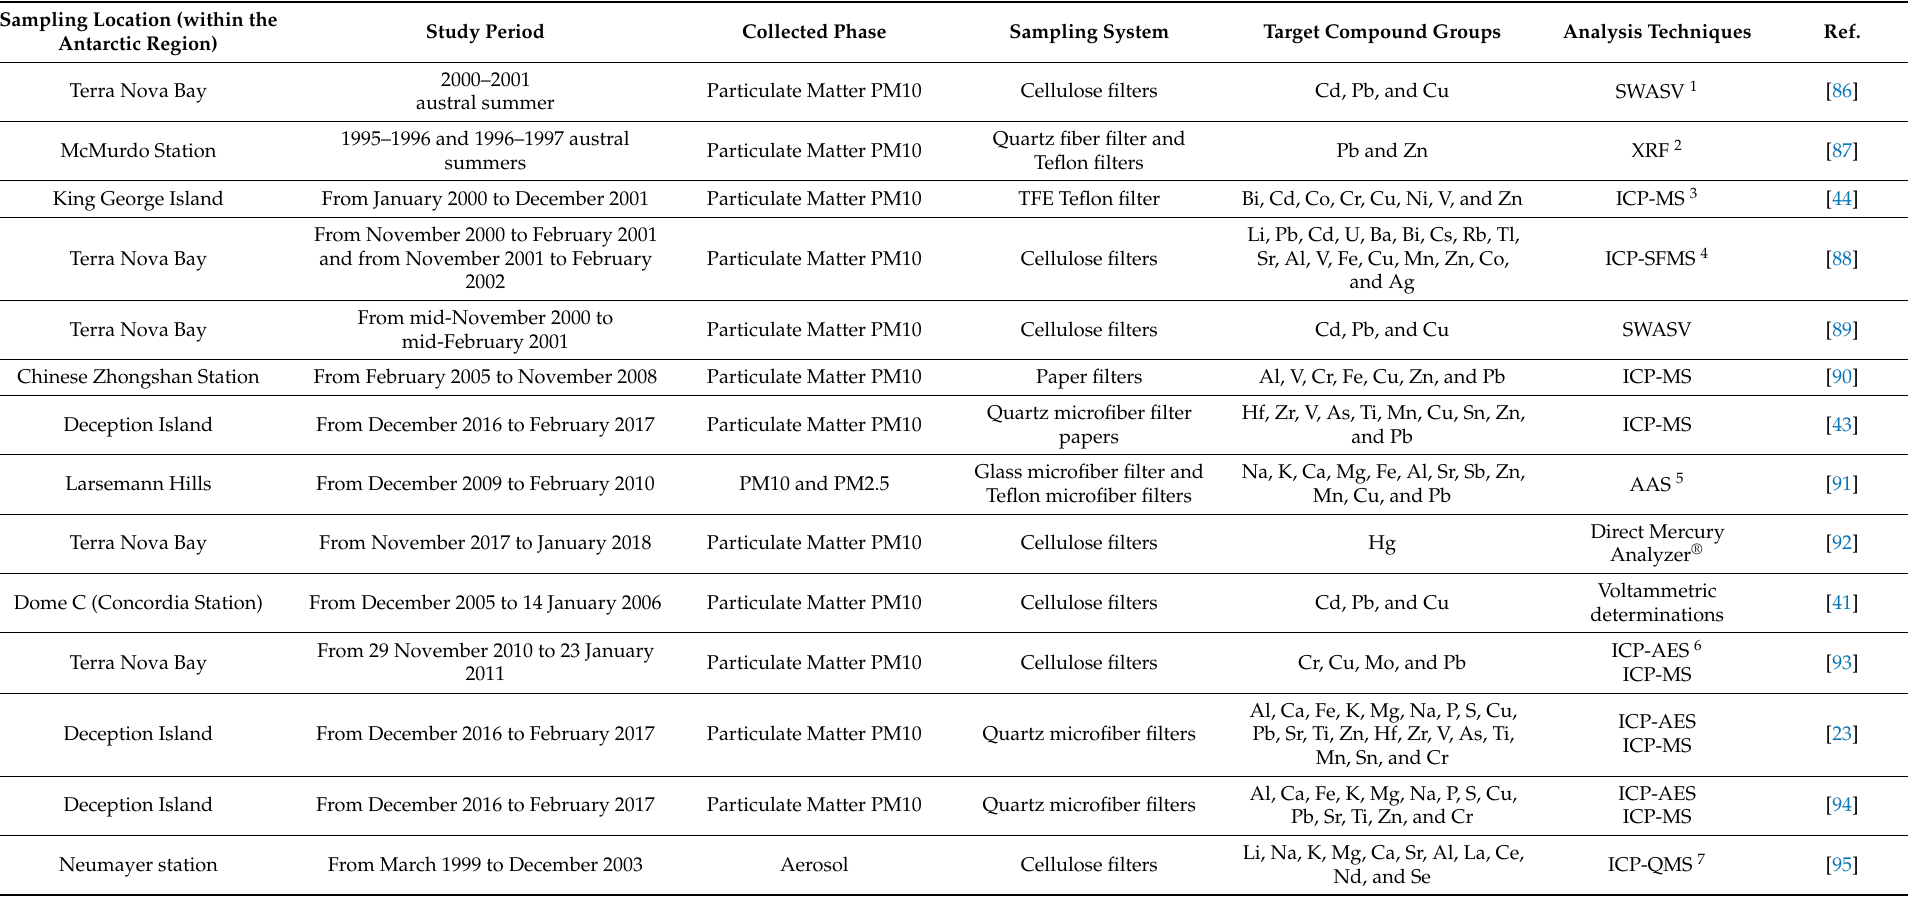
Table 2. Compilation of investigation studies (from 2001) on metal traces carried out in the air of Antarctica. Sampling Location (within the Antarctic